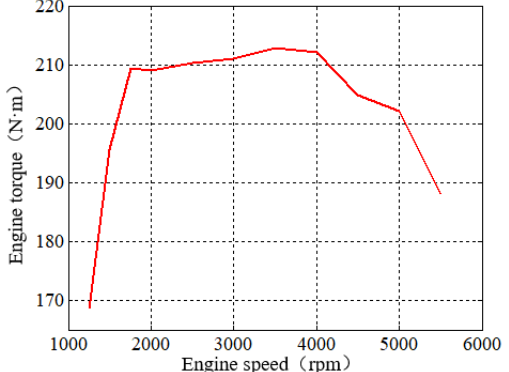
Figure 3. External characteristic curve of engine driving torque.